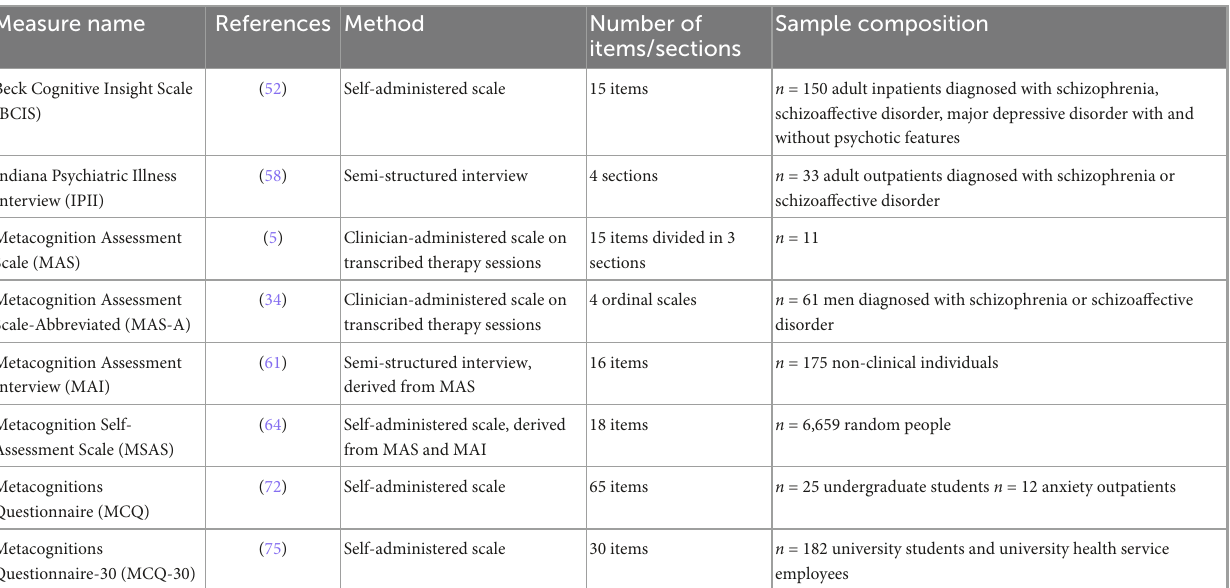
TABLE 1 English language measures of